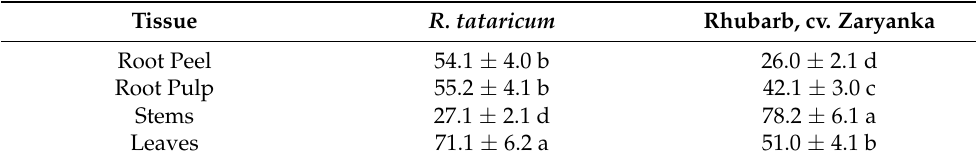
Table 2. Proline content in rhubarb root peel and pulp (mg kg − 1 d.w.). Tissue